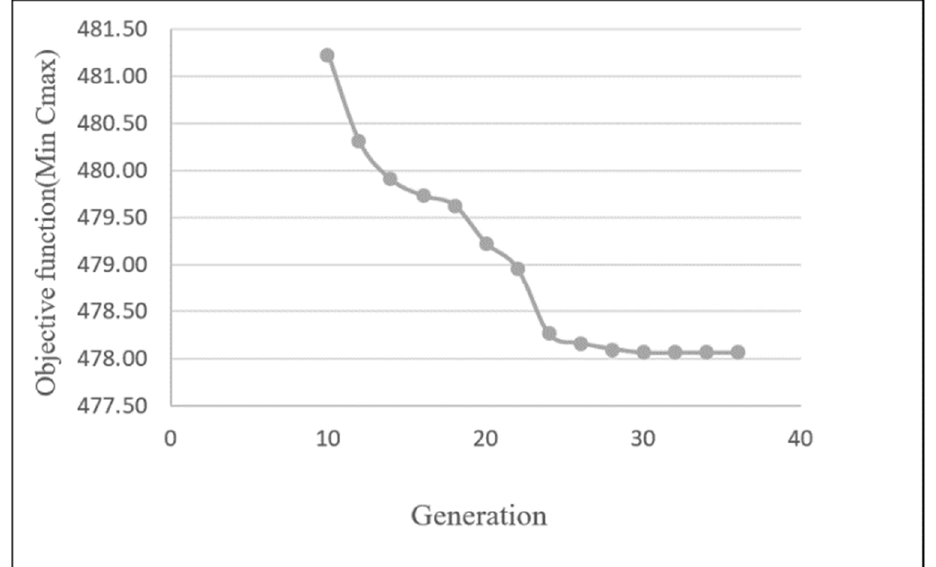
Figure 8. HGAG convergence for the RFFS_SDST_SDST_60 × 4 × 4 × 25 instance.